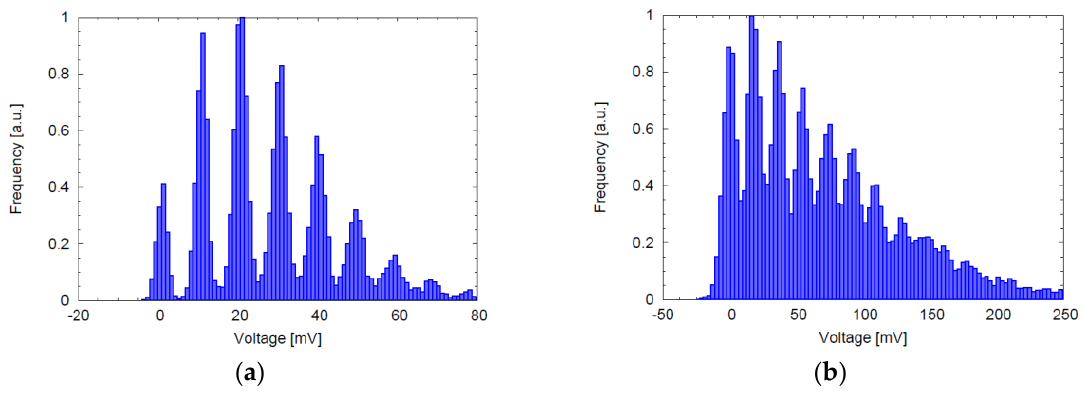
Figure 10. Pixel analog output histograms for the analog counting pixels of [19] and [36], depicted in ( a ) and ( b ), respectively.